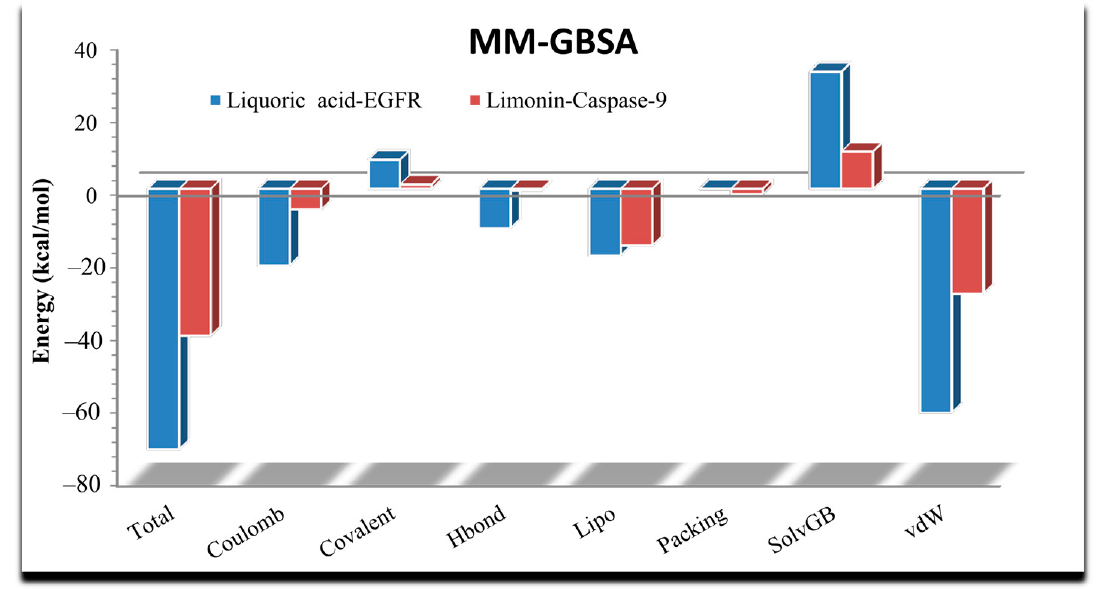
Figure 11. MM-GBSA analysis to predict binding energy between receptors and the ligands (liquoric acid and limonin). The total binding free energy of MM-GBSA was determined by adding seven energies given at the bottom of the chart.